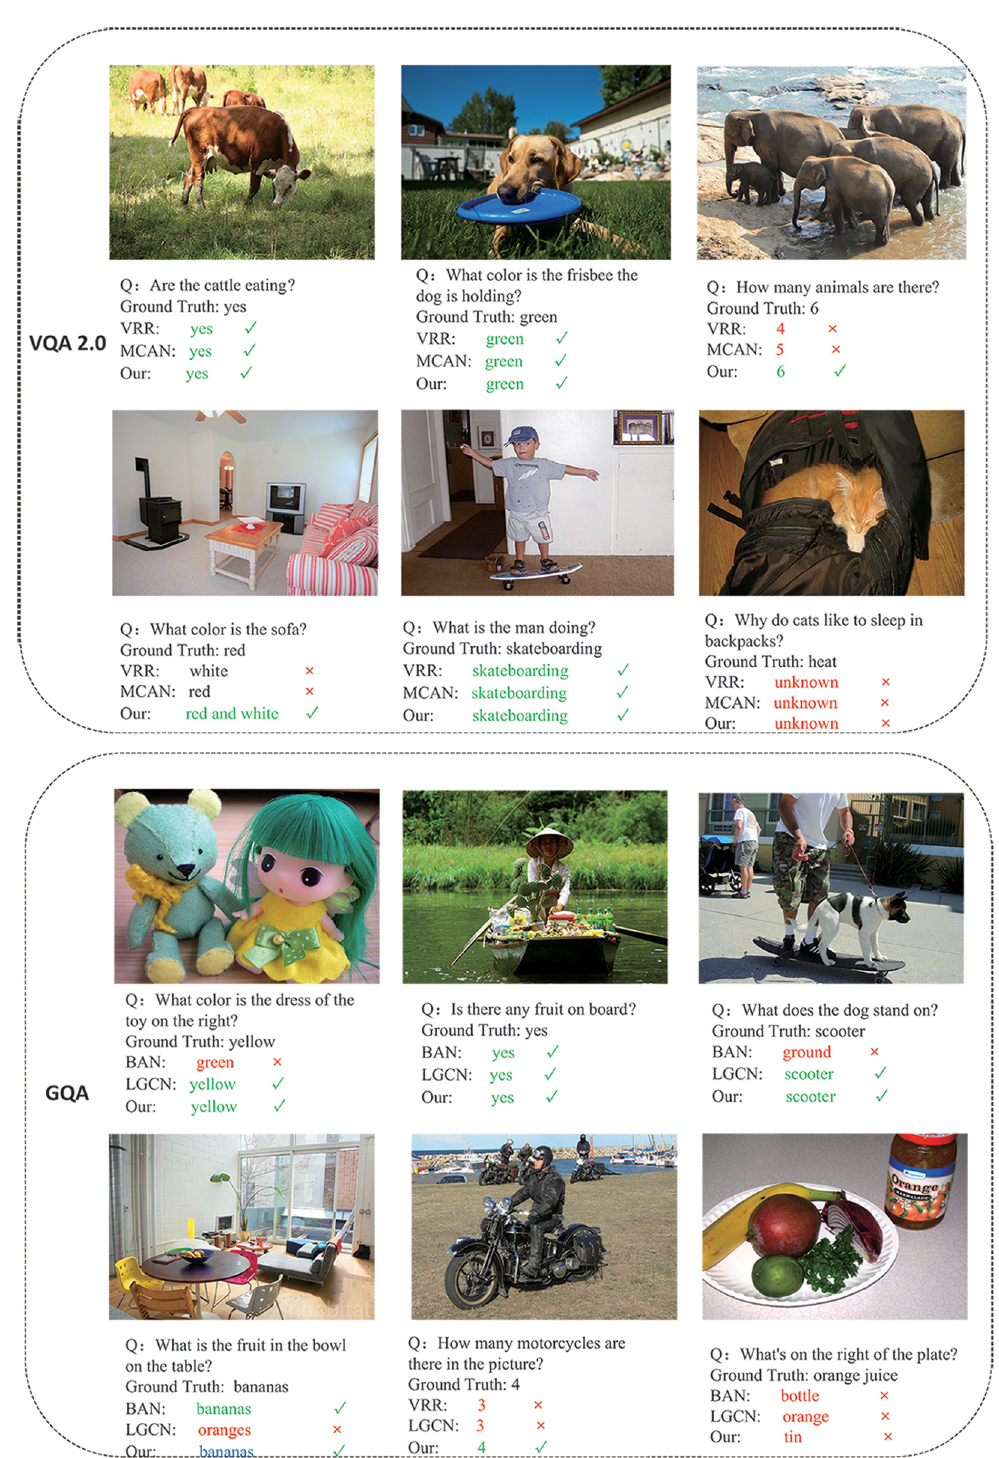
Fig 8. Example of visualization on VQA 2.0 and GQA datasets.